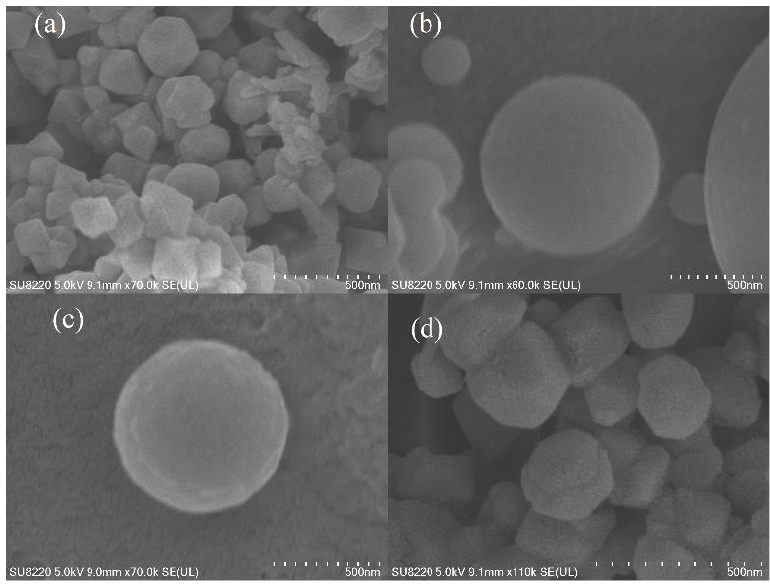
Figure 2. SEM images of AAM-MSMPM (PEG/MeOH = 15 wt %) ( a ), AAM-MSMPM (PEG/MeOH = 20 wt %) ( b , c ), and Cd(II)/AAM-MSMPM ( d ).